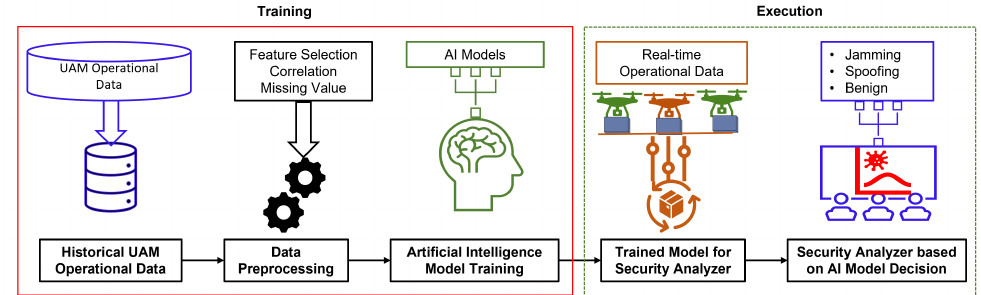
Figure 2. Modular view of the proposed artificial intelligence-enabled exploratory cyber-physical safety analyzer framework for civilian urban air mobility